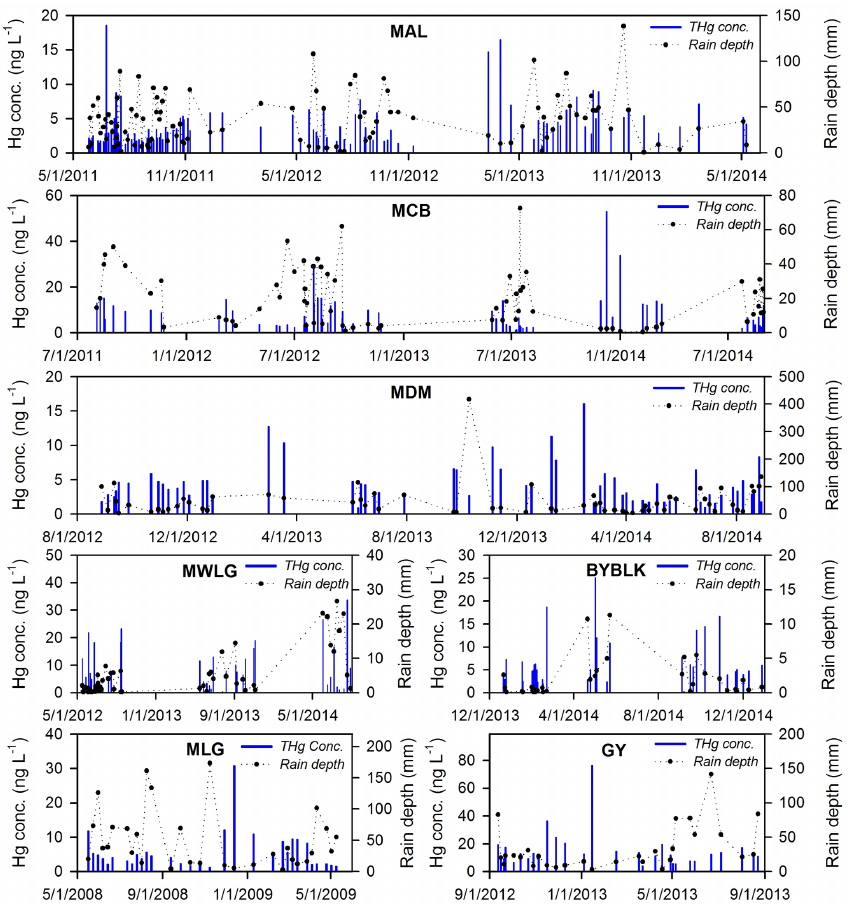
Figure 2. Mercury concentration and rain depth in a single precipitation event at Mt. Ailao (MAL), Mt. Changbai (MCB), Mt. Damei (MDM), Mt. Waliguan (MWLG), Bayinbuluk (BYBLK), Mt. Leigong (MLG) and urban Guiyang (GY) in this study.